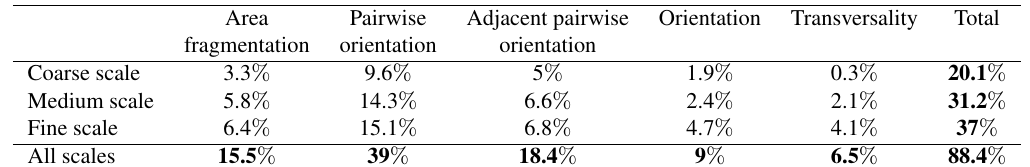
Table 1: Feature importance in the classifier by using the Princeton Shape Benchmark. In addition to the histogram features per scale there is the oriented bounding box ratio as a single scalar feature with importance 11.6 % .